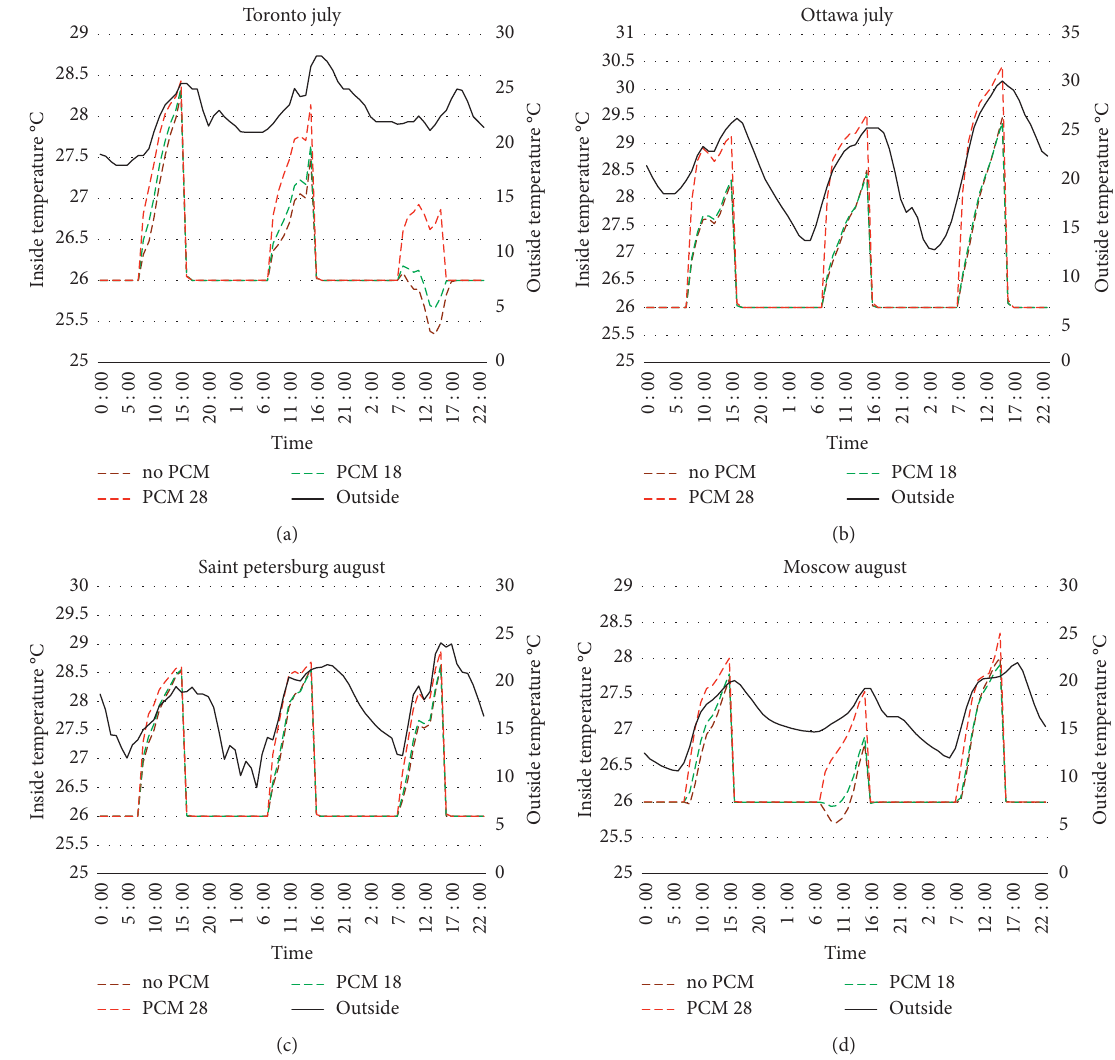
Figure 10: Temperature profiles for representative cities for months with the lowest energy savings.